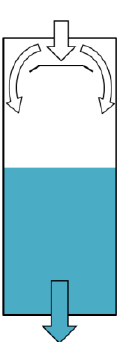
Figure 10. Inside the air/oil converter.